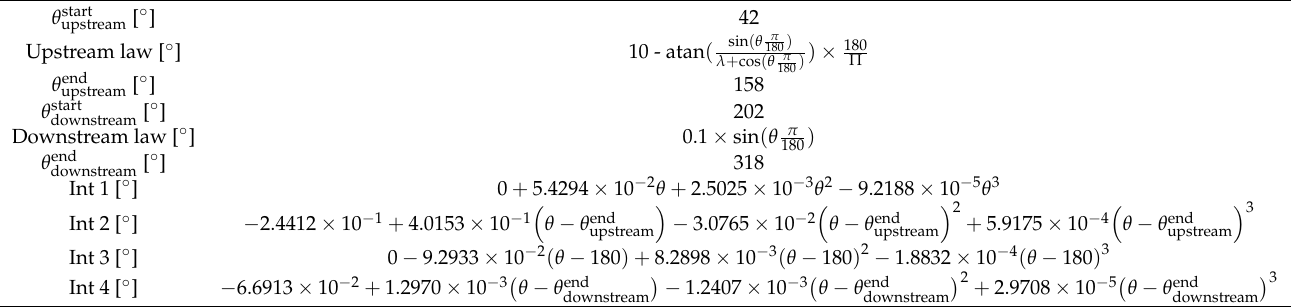
Table A3. Details of pitching law PL3 ( θ is always in degrees ( ◦ ) in the expressions).